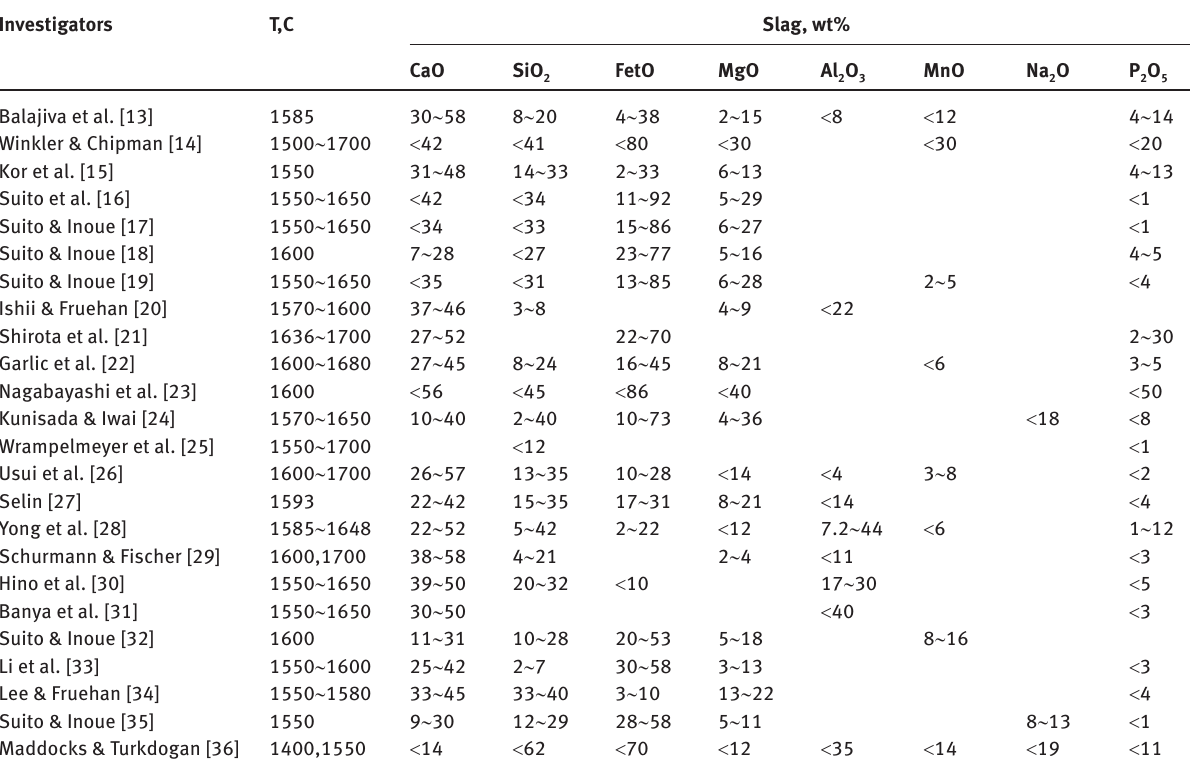
Table 2: Experimental conditions of the literature data on P distribution between slag and metal